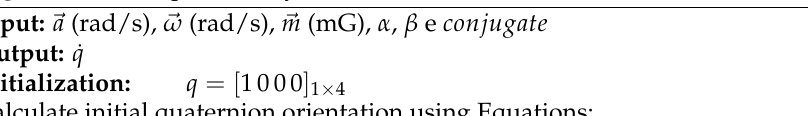
Algorithm 1 Complementary